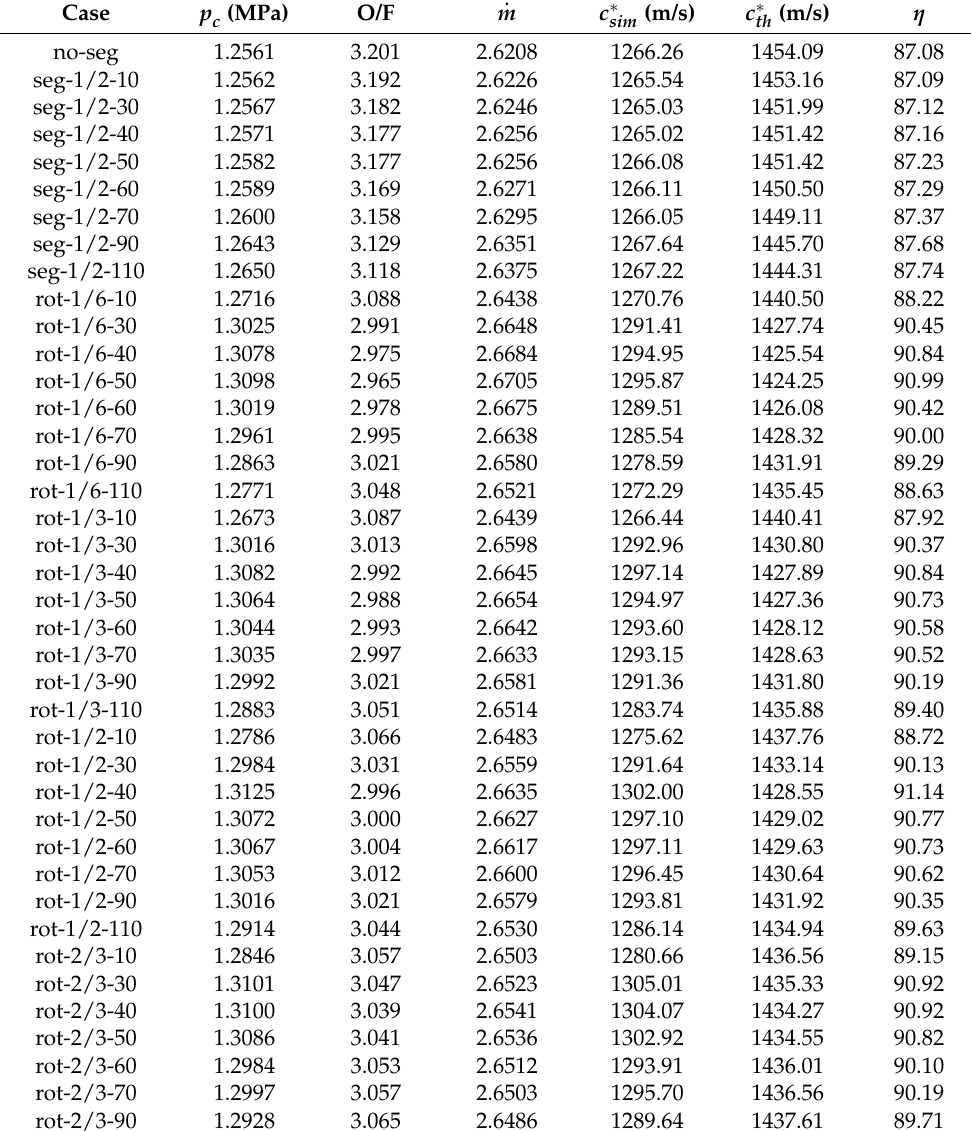
Table 6. Performance parameters obtained from the numerical